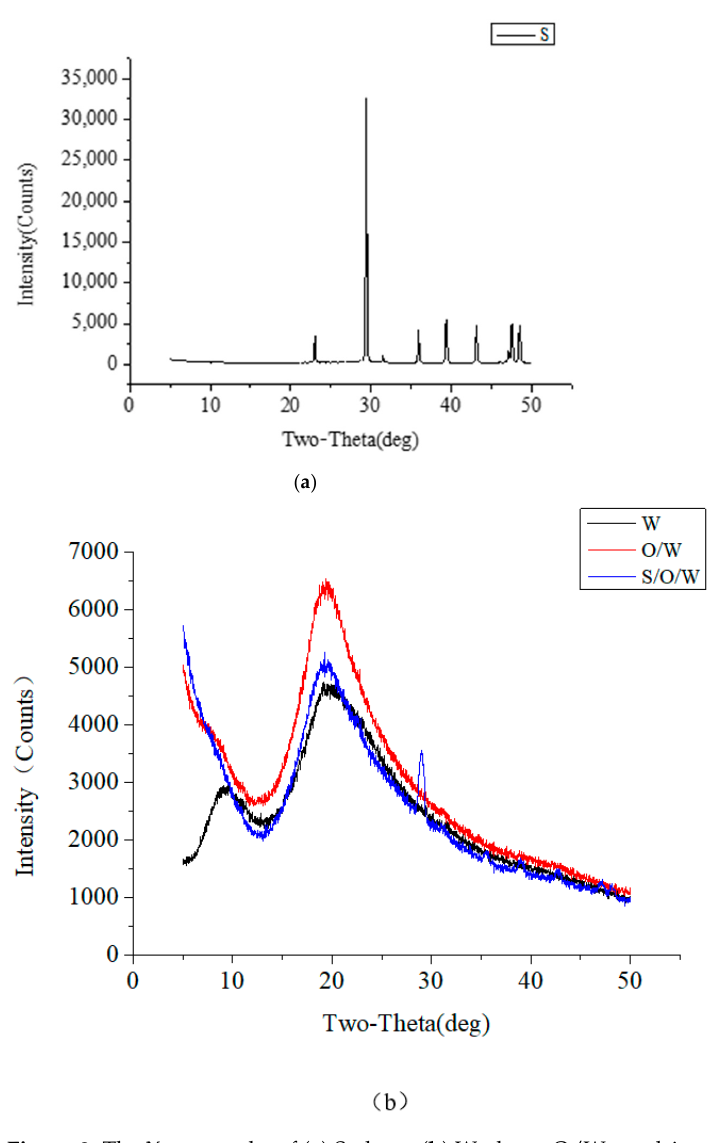
Figure 8. The X-ray results of ( a ) S phase, ( b ) W phase, O/W emulsions, and S/O/W emulsions.